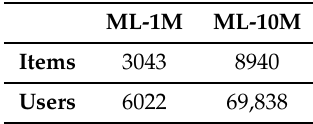
Table 1. Final number of items and users of datasets MovieLens.